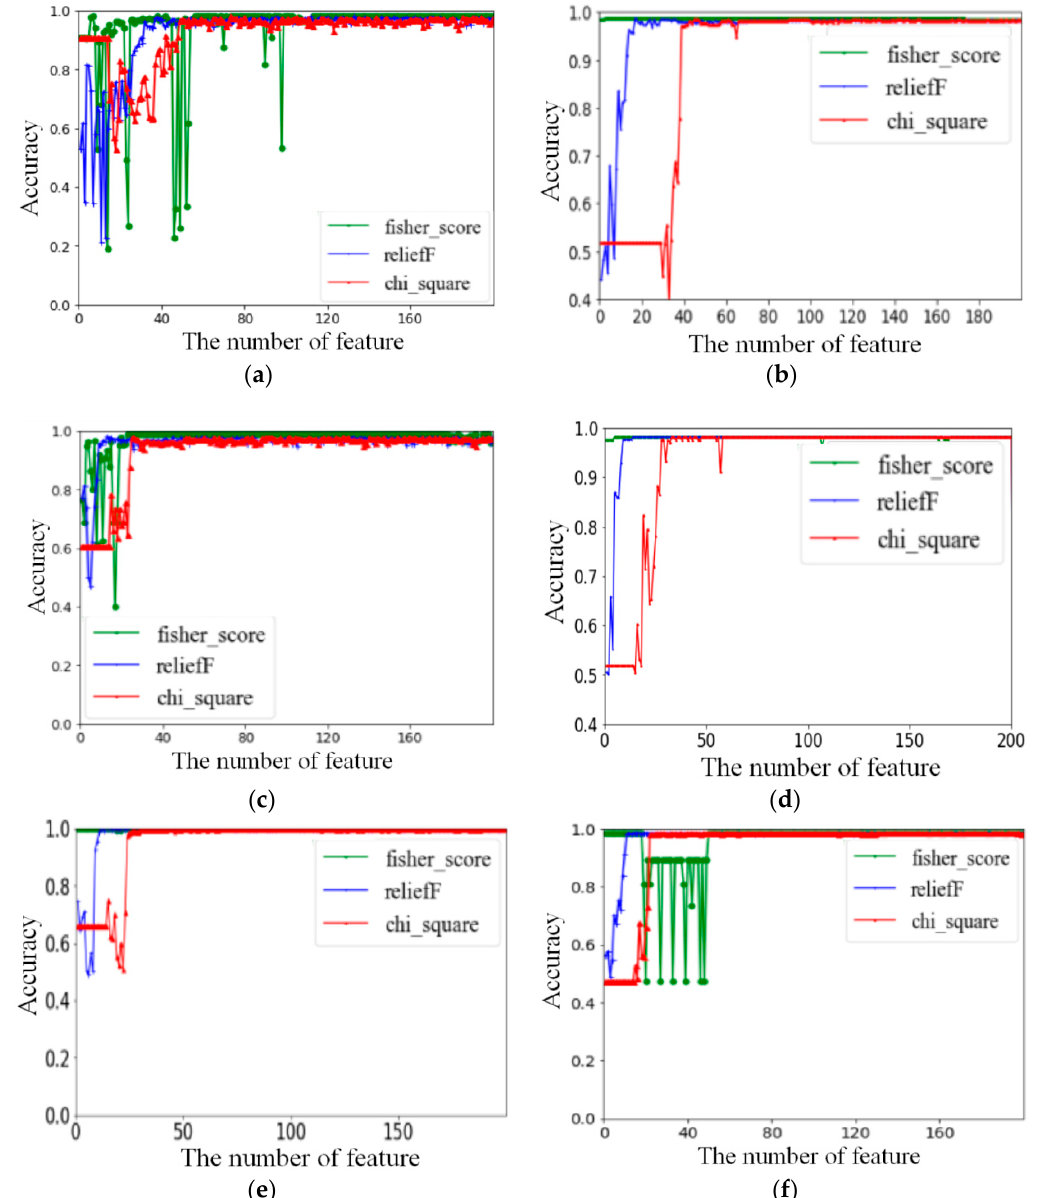
Figure 4. The comparison of the classification accuracy and the number of selected features in the six layers. The first layer: basic activities and postural transitions ( a ); the second layer: static state and dynamic state ( b ); the third layer: walking, going upstairs, and downstairs ( c ); the fourth layer: going upstairs and downstairs ( d ); the fifth layer: standing, sitting, and lying ( e ); and the sixth layer: sitting and lying ( f ).